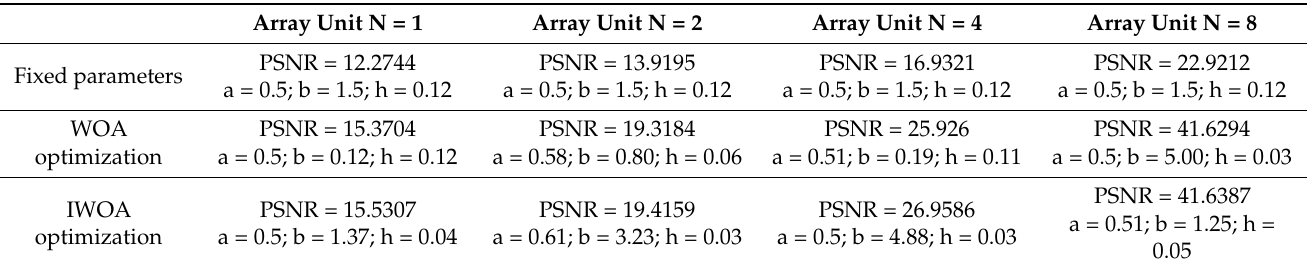
Table 4. Baboon image PSNR under different array saturation model methods (dB).